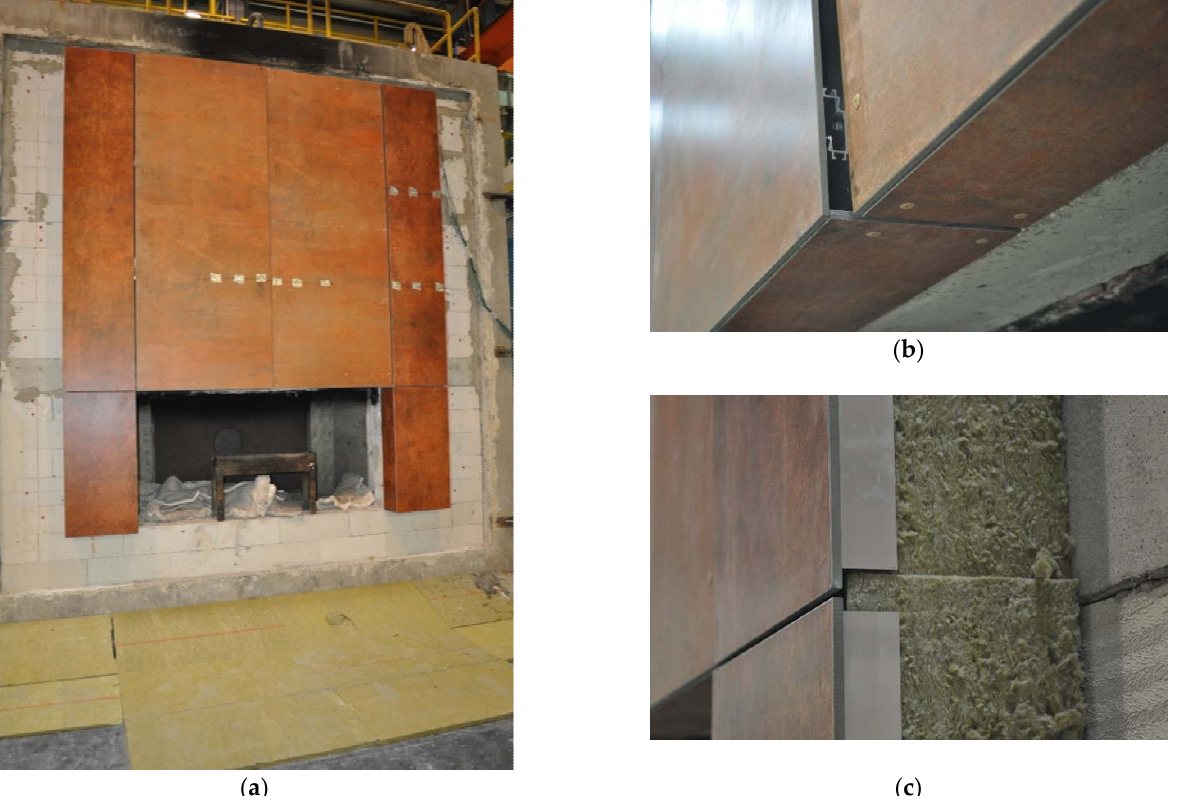
Figure 3. Selected details of the large-scale facade model: ( a ) actual elevation model view; ( b ) eaves problem and solution; ( c ) insulation.